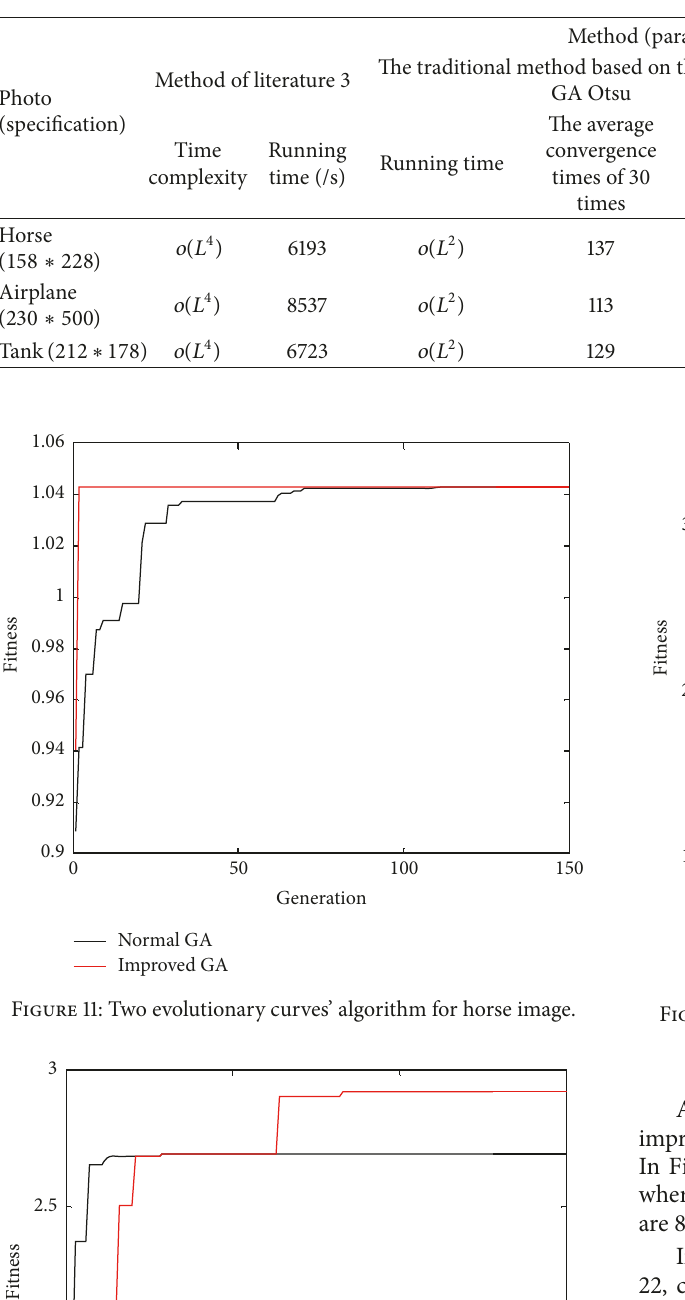
Table 2: Comparison of the running time of several two-dimensional Otsu algorithms.